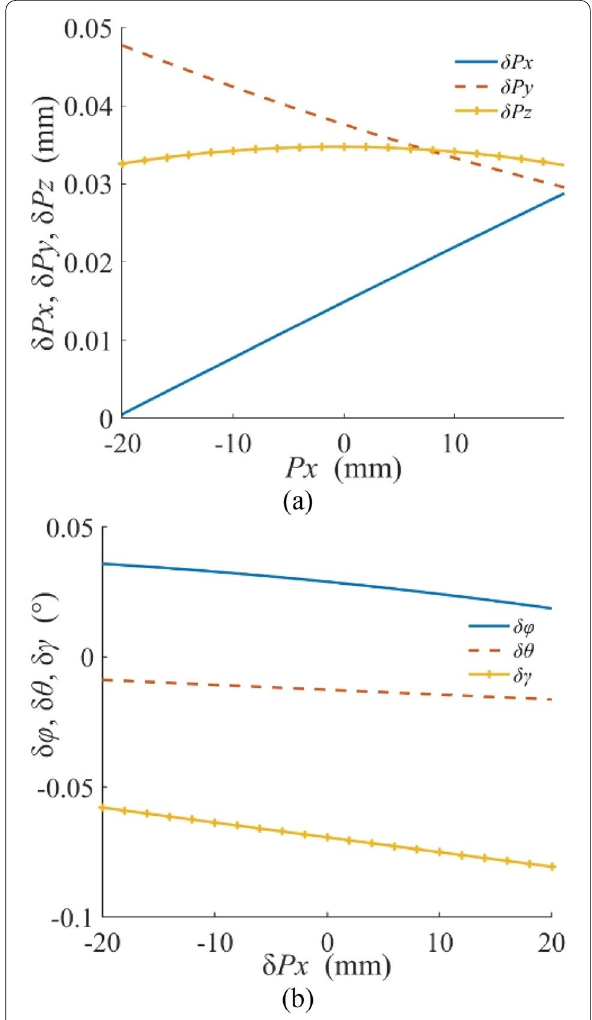
Figure 19 Relation between pose parameter P x and output pose errors: a δ P x , δ P y , δ P z to P x , b δ φ , δ θ , δ γ to P